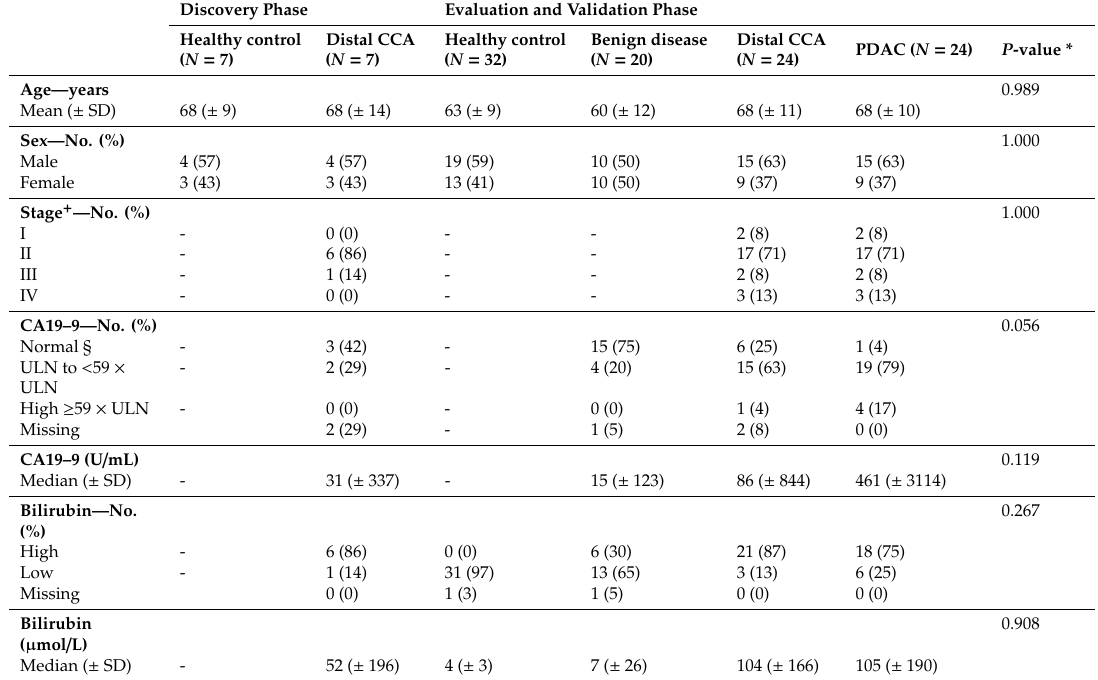
Table 1. Clinicopathological Characteristics of the Included